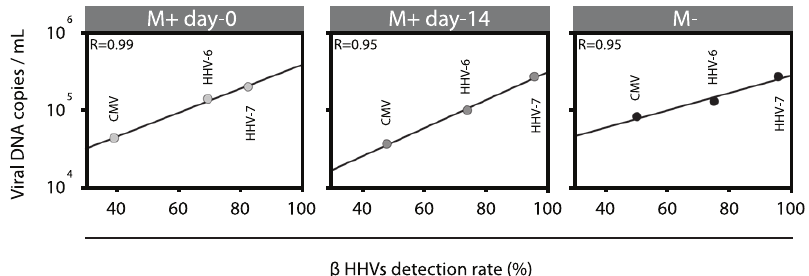
Figure 4. b herpes viruses prevalence and shedding. Correlation established by linear regression analysis between b herpes viruses loads during salivary shedding (data from Figure 3) and b herpes viruses prevalence (detection rate) in all the saliva sample analyzed. (M + day-0; light gray circles), (M + day-14; dark gray circles), (M 2 ; black circles).